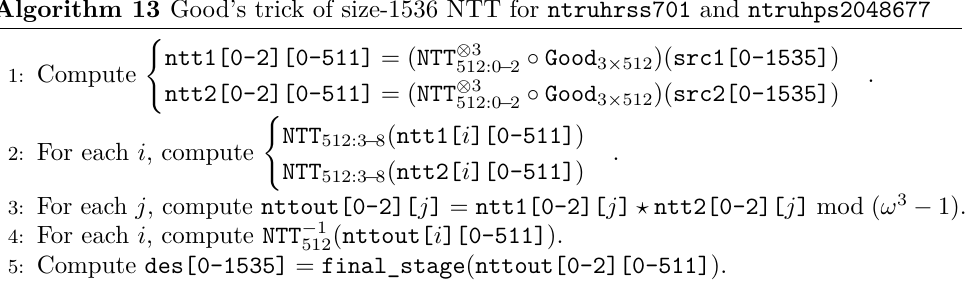
Algorithm 13 Good’s trick of size-1536 NTT for ntruhrss701 and ntruhps2048677